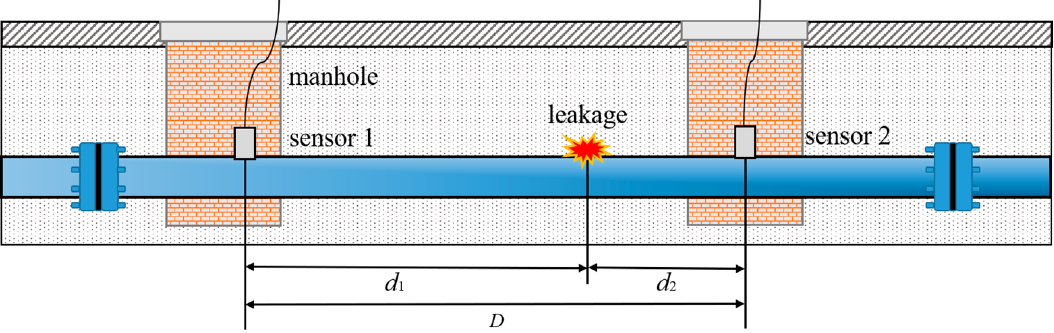
Figure 1. Schematic of leak detection measurements in water distribution pipes.